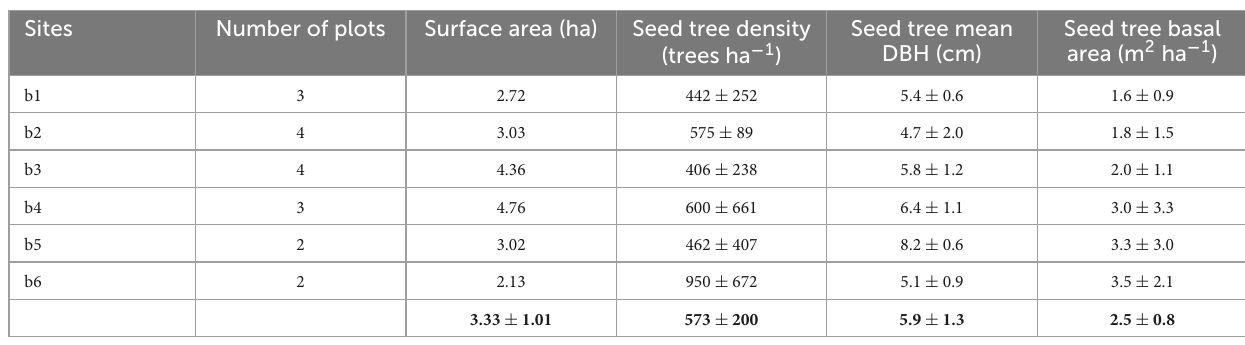
TABLE 1 Characteristics of the six study lichen